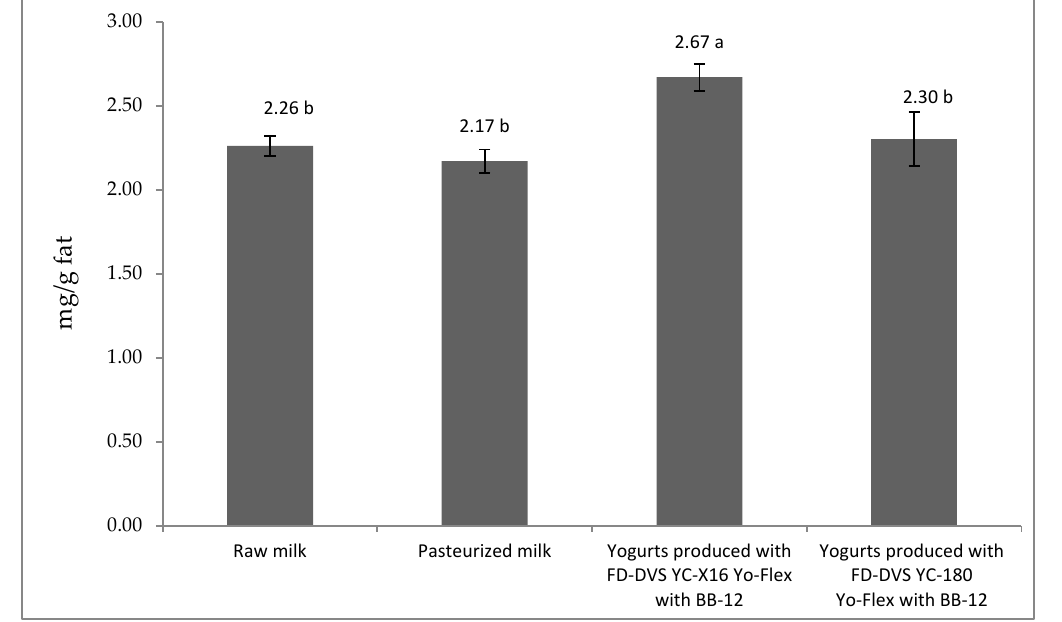
Figure 1. The content of cis-9,trans-11 C18:2 (CLA) in raw milk, pasteurized milk, and yogurts produced. n = 4 for raw and pasteurized milk; n = 8 for yogurts; a,b —values with different letters differ significantly ( p < 0.05). Table 2. Microelements in milk and yogurts produced ( µ g/100 g wet weight).